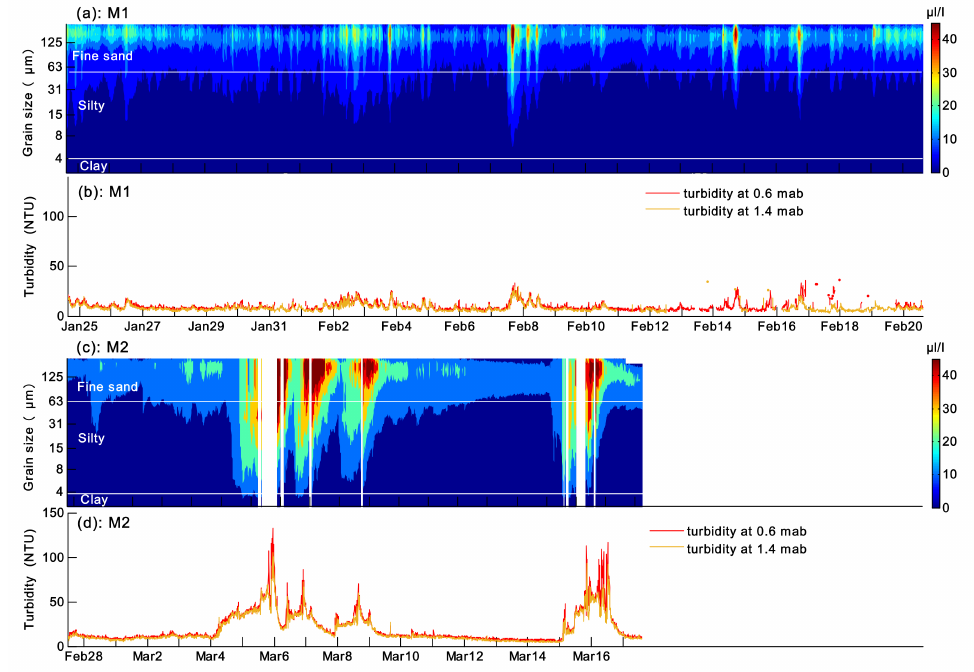
Figure 8. Volume concentration, particle size distribution ( a , c ), and water turbidity ( b , d ) at the bottom layer at M1 and M2 stations, respectively, measured by LISST ( a , c ) and OBS ( b , d